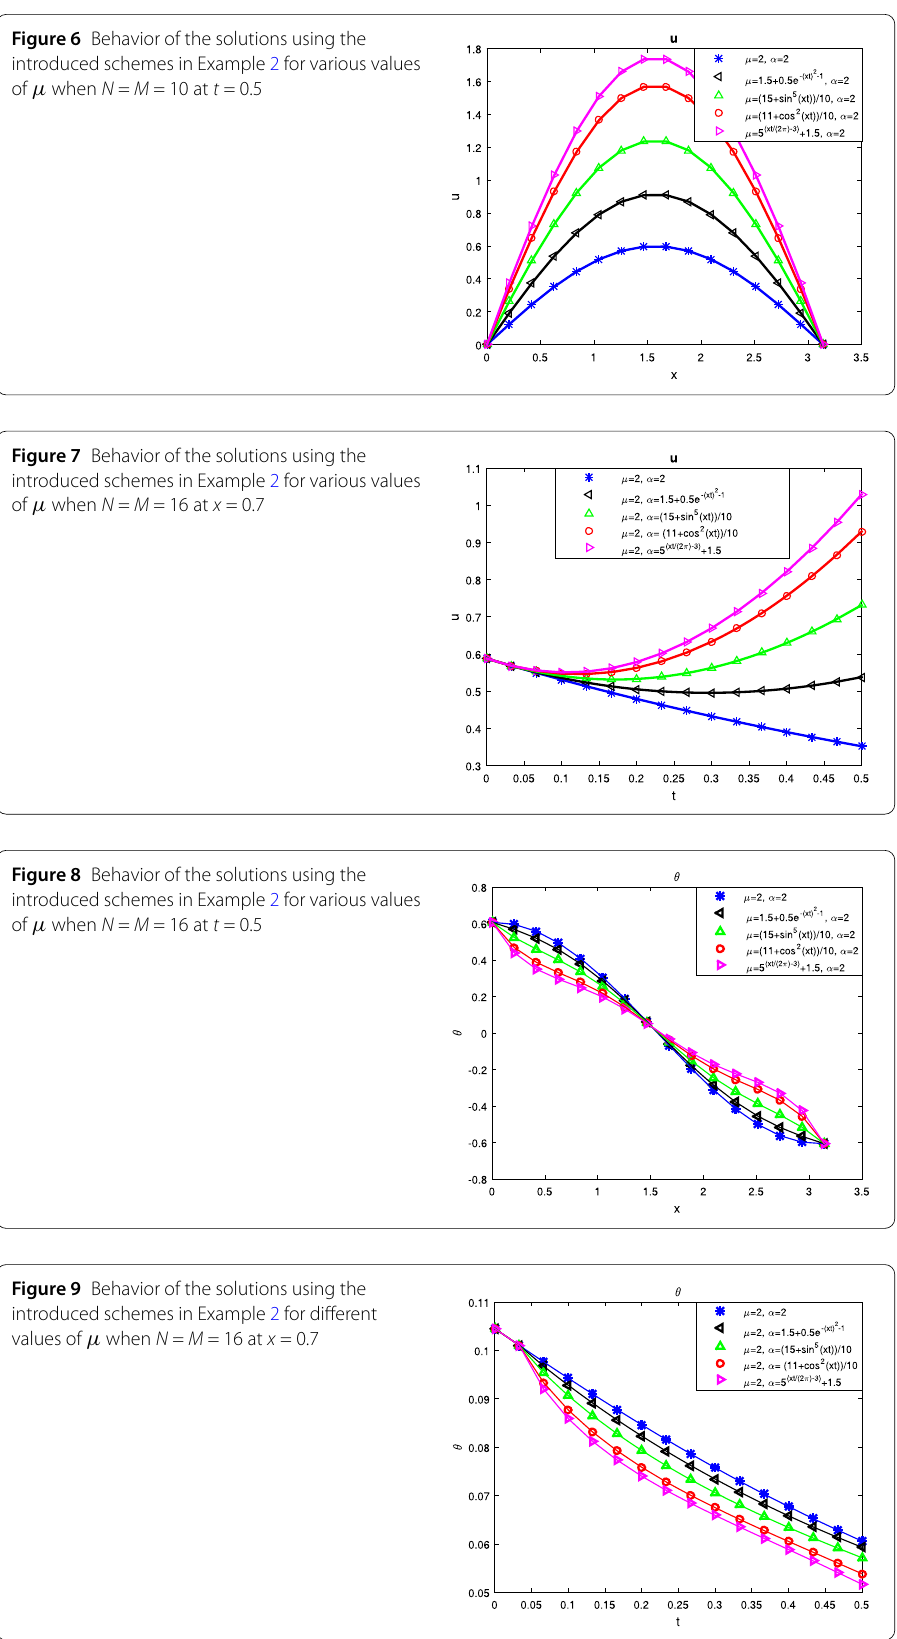
Figure 6 Behavior of the solutions using the introduced schemes in Example 2 for various values of μ when N = M = 10 at t = 0.5